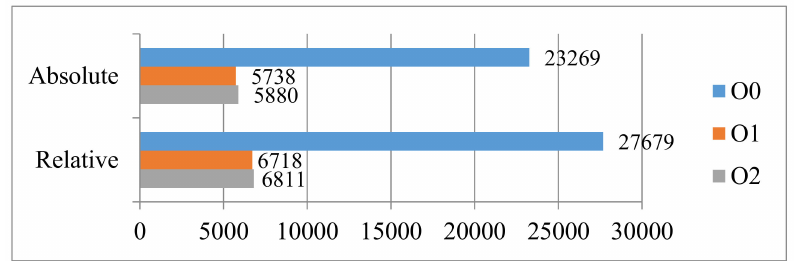
Figure 10. The WCET obtained from different optimization levels of compiler (unit: